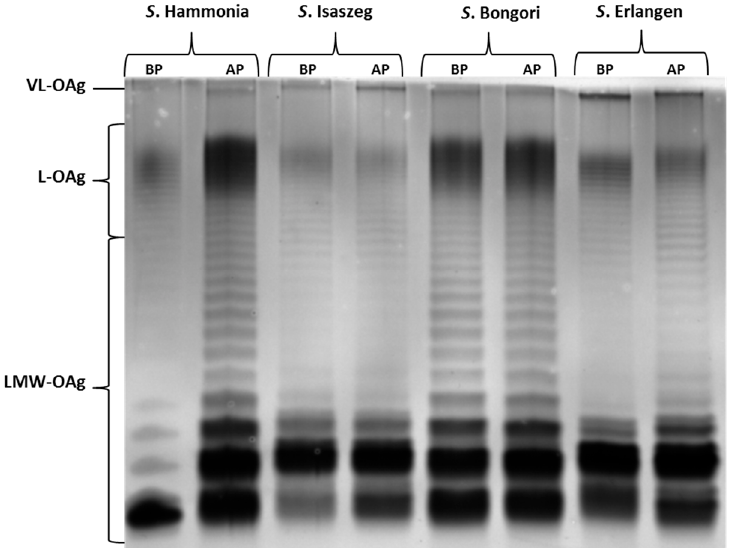
Figure 2. Lipopolysaccharide (LPS) profiles of four Salmonella O48 strains before (BP) and after (AP) nine passages in 50% normal human serum. VL-OAg: very long O-antigen; L-OAg: long O-antigen; LMW-OAg: low molecular weight O-antigen.